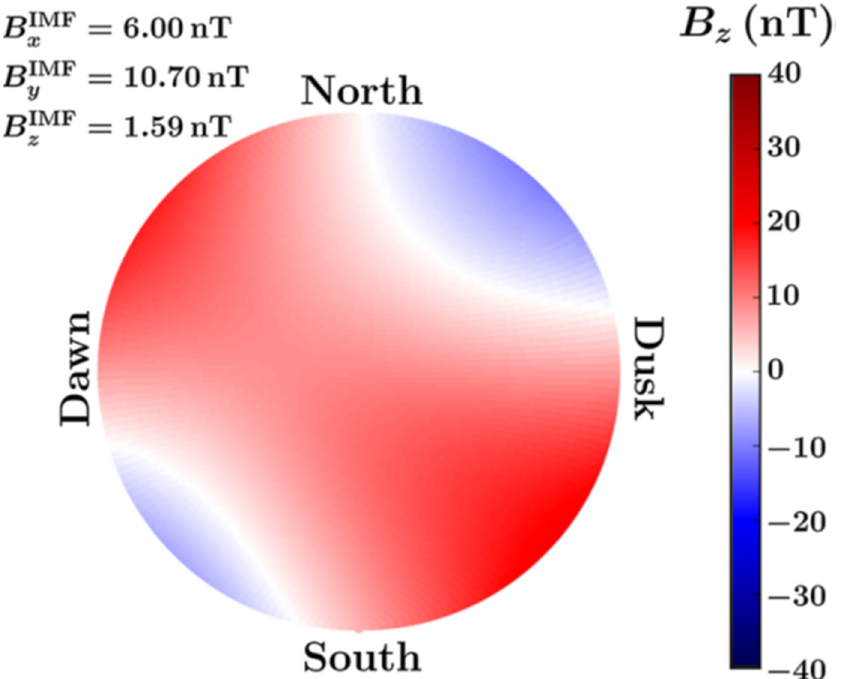
Figure 8. Magnetic field Bz component along the magnetopause for a weakly northward IMF semi-analytical magnetosheath model based on ideal MHD